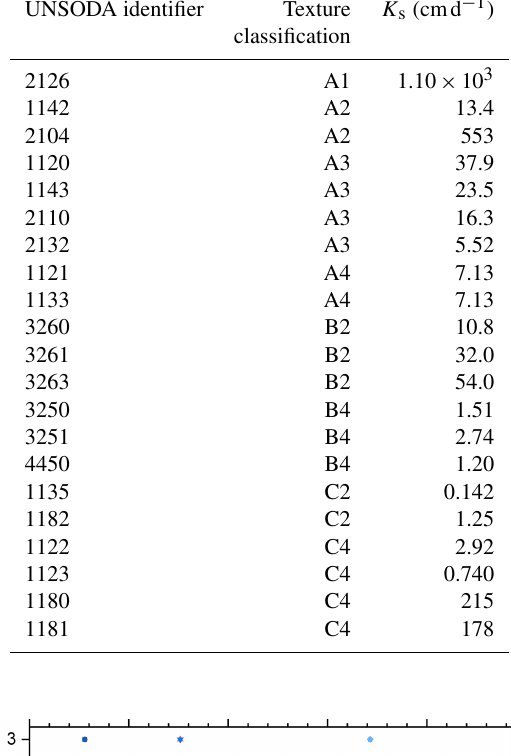
Table C9. Values for the hydraulic conductivity at saturation ( K s ) for the selected soils from the UNSODA database. The soils are identified by their UNSODA identifier. Their classification accord- ing to Twarakavi et al. (2010) is also given.